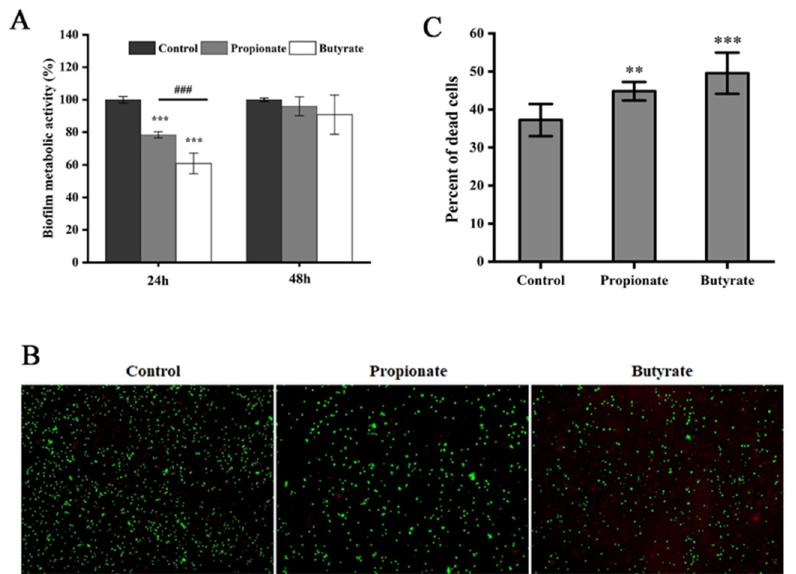
Figure 4. The biofilm metabolic activity of S. Typhimurium SL1344 was analyzed by ( A ) XTT assay, ( B ) fluorescence staining, and ( C ) quantitative analysis by Image J. “**”, and “***” indicates significance compared to the control. “ ### ” indicates significance between different SCFAs treatments. “**” p < 0.01, “***” “ ### ” p < 0.001.